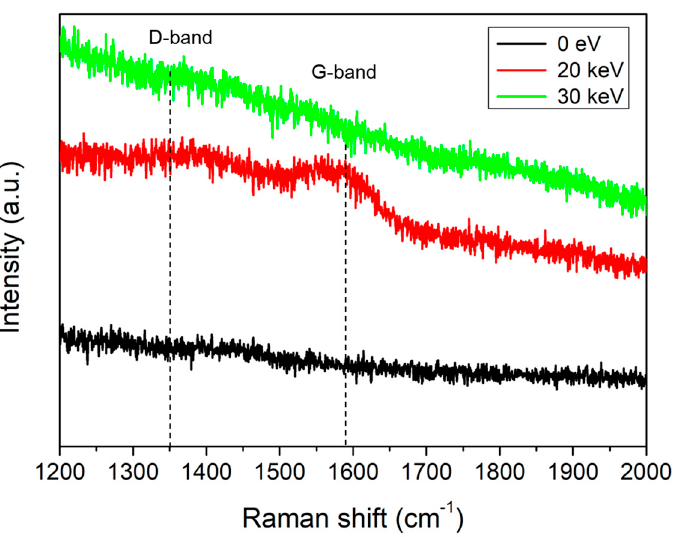
Figure 3. Raman spectrum waveband (1200 cm − 1 to 2000 cm − 1 ) after irradiating electron beams with acceleration voltages of 0 eV, 20 keV, and 30 keV around the aperture hole of a Si electron lens fabricated using the MEMS process for 24 h.